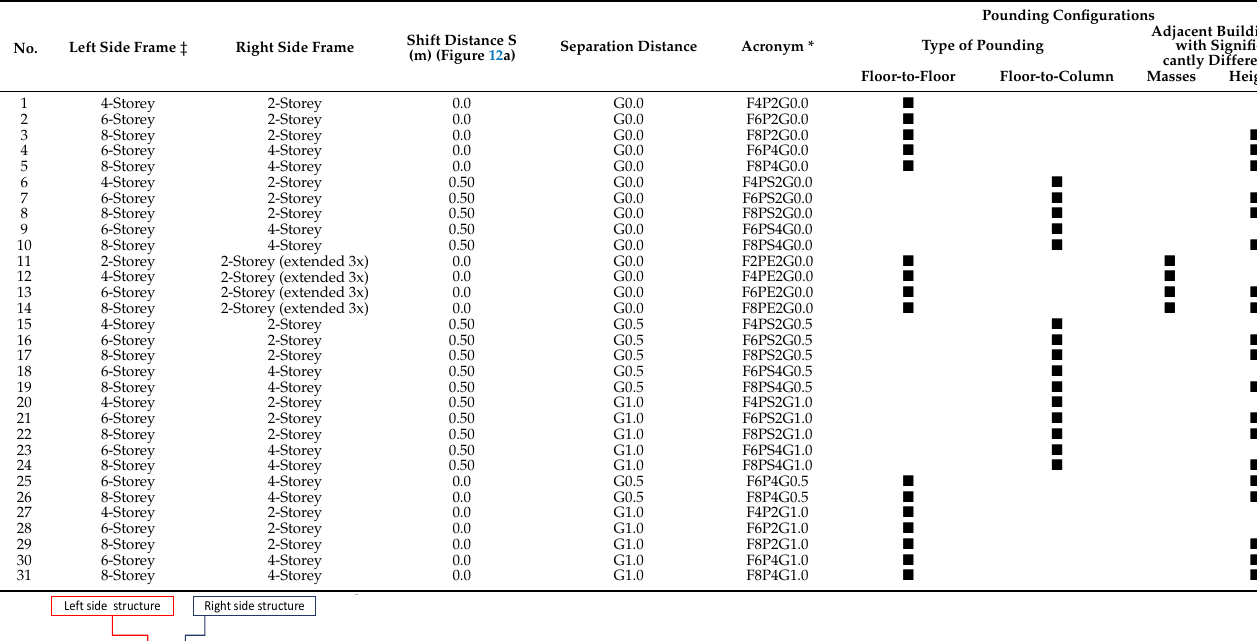
Separation distance